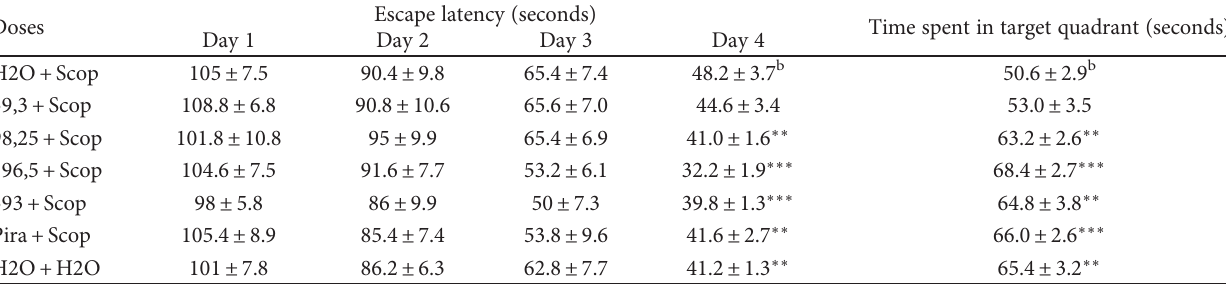
Table 5: E ff ect of M. inermis in scopolamine-induced cognitive impairment mice in MWM.